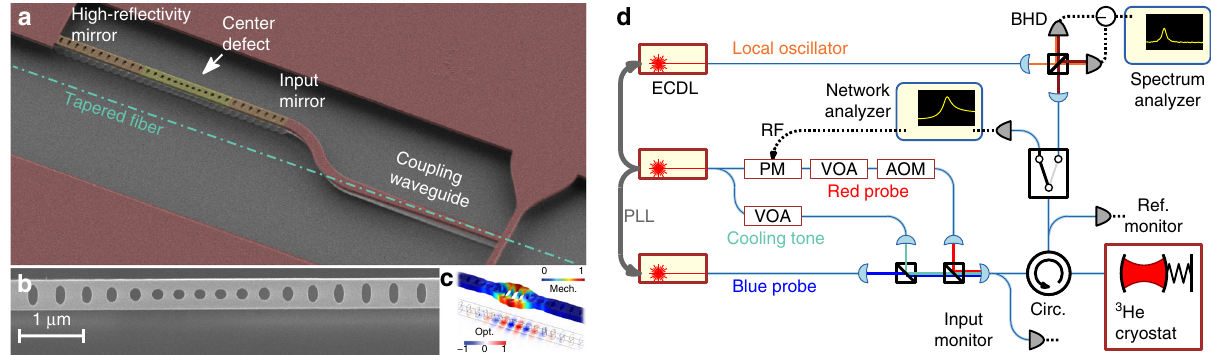
Fig. 2 Optomechanical crystal and experimental setup. a False-color SEM image of the silicon optomechanical crystal cavity with a waveguide for laser input coupling. The path of the tapered fi ber is indicated. b SEM image detail of the cavity. c Illustration of the mechanical breathing mode and optical mode. d Experimental setup. AOM, acousto-optical modulator; BHD, balanced heterodyne detector; ECDL, external-cavity diode laser; PLL, phase-locked loop; PM, phase modulator; VOA, variable optical